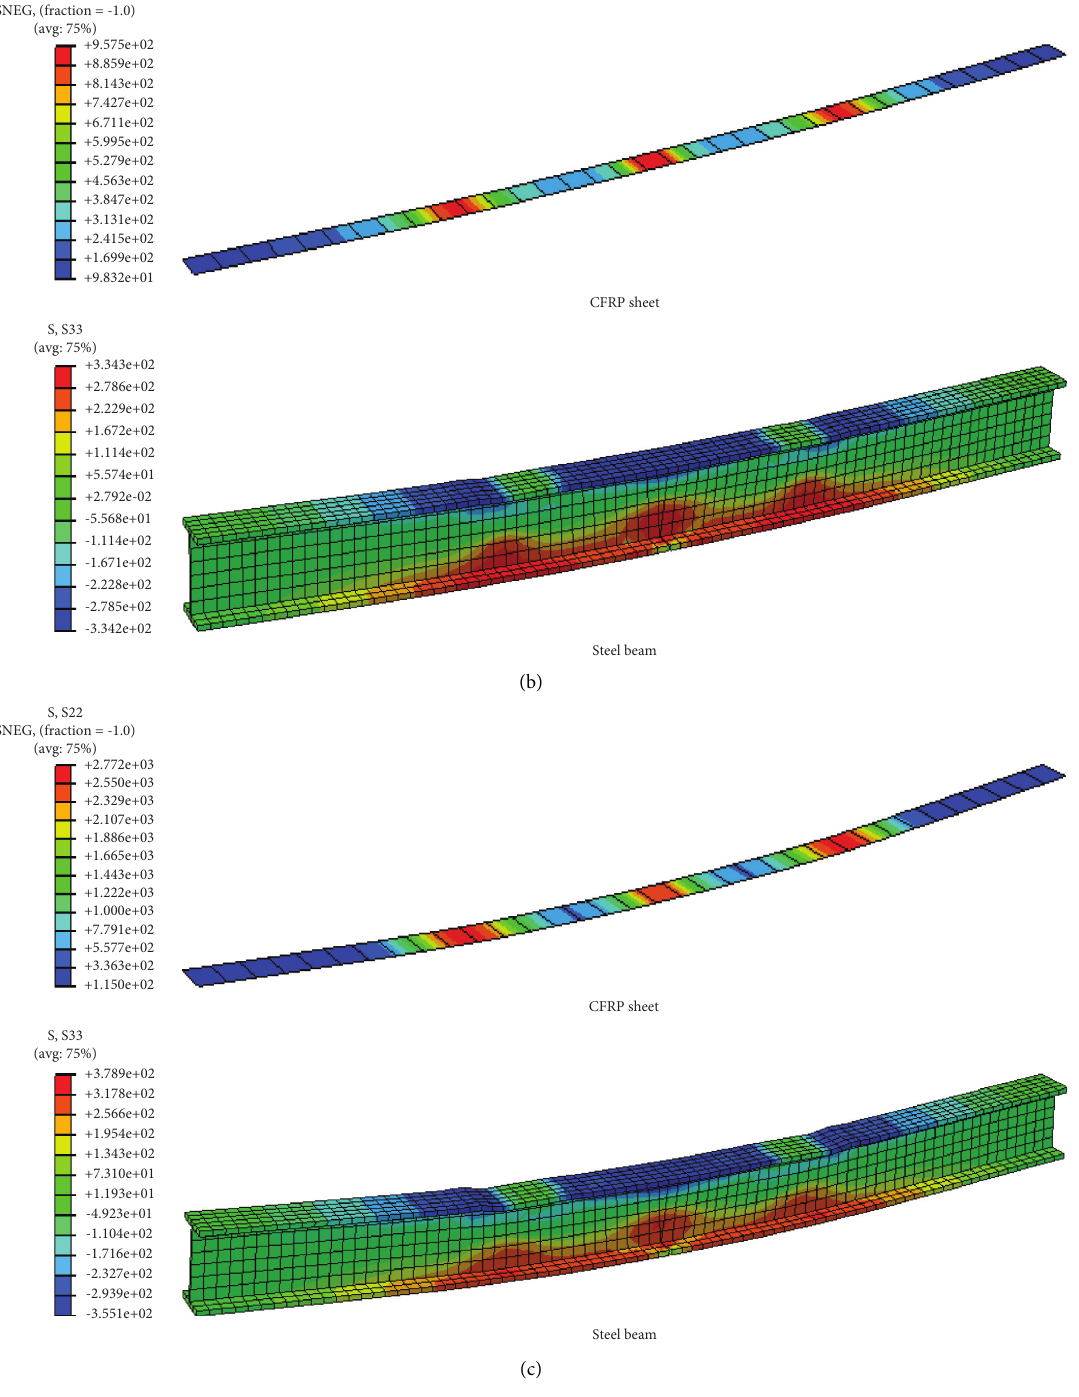
Figure 10: Stress images. (a) 33%Pu. (b) 66%Pu. (c) 100%